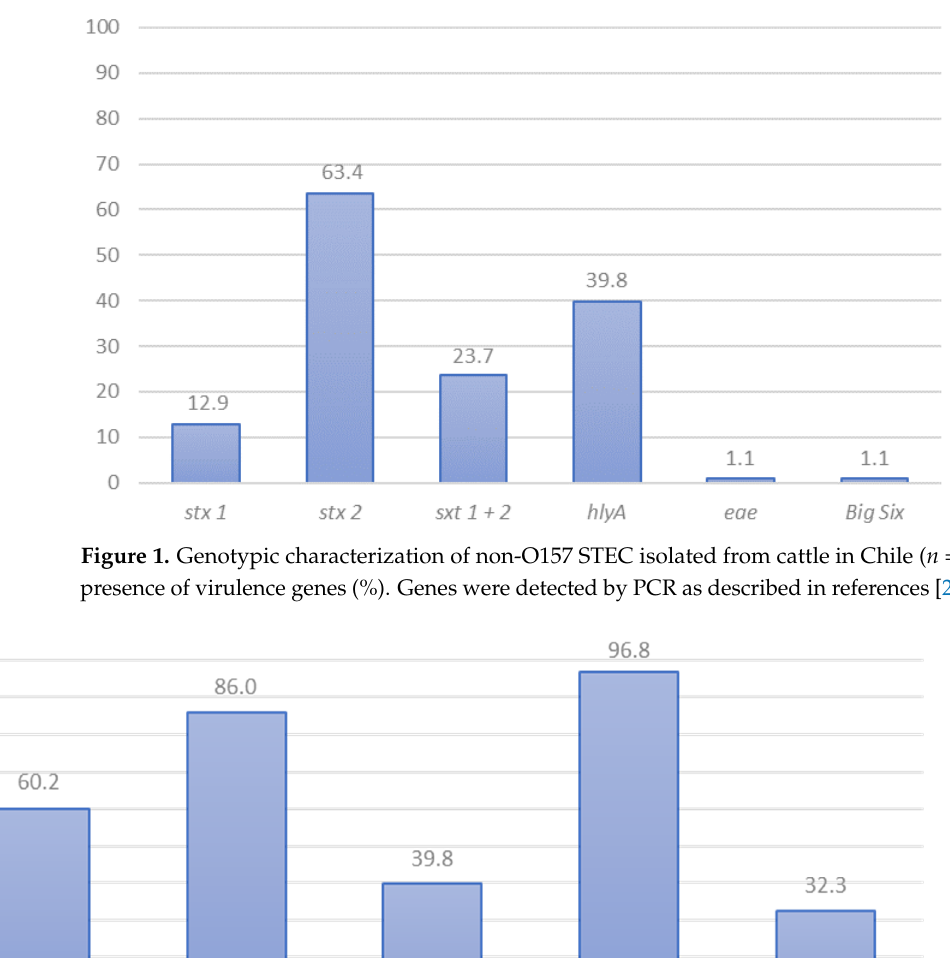
Table 3. STEC screening and isolation rates in cattle from central and southern farms in Chile.